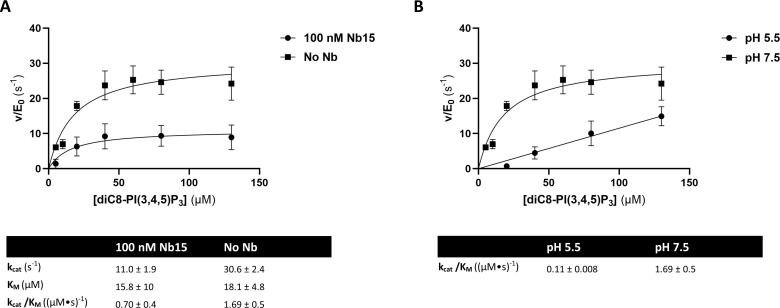
The 5-phosphatase activity of Synj1528–873 is affected by Nb15 and acidic pH.(A) Michaelis-Menten curves obtained by using the Malachite green assay with 2.5 nM of human Synj1528–873 and various concentrations of diC8-PI(3,4,5)P3 in absence or presence of 100 nM Nb15. (B) Michaelis-Menten curves obtained by using the Malachite green assay with 2.5 nM of human Synj1528–873 and various concentration of diC8-PI(3,4,5)P3 in assay buffer containing 25 mM HEPES at pH 7.5 or in assay buffer containing 25 mM sodium citrate at pH 5.5. The turnover number (kcat), the Michaelis-Menten constant (KM), and specificity constant (kcat/KM) are given for the different measurements, together with the standard error. Each datapoint is the average of three independent measurements with the error bars representing the standard deviation.Figure 4—figure supplement 1—source data 1.Steady-state enzyme kinetics data of Synj1528–873 wild-type using diC8-PI(3,4,5)P3 as substrate at pH 5.5 and in presence of an excess of Nb15 (comparable to the crystallization conditions).